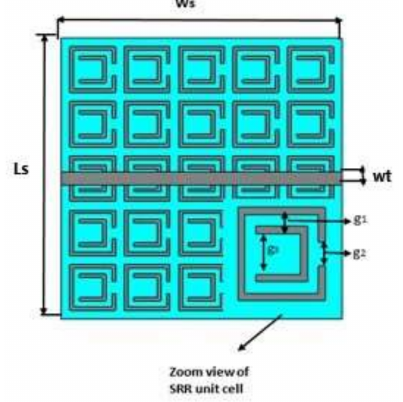
Figure 5. Geometric model of the dual-band